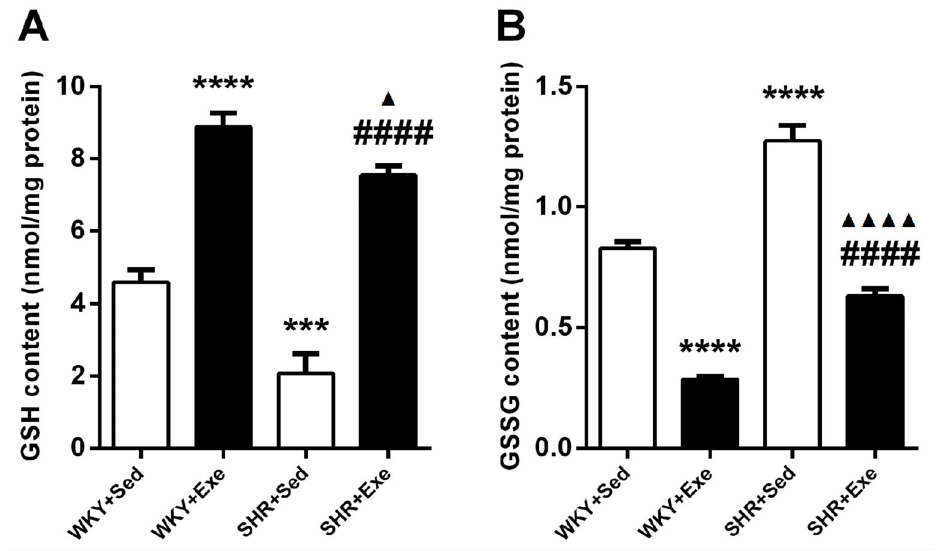
Figure 4. Cardiac GSH ( A ) and GSSG ( B ) levels were measured in sedentary or exercised Wistar-Kyoto rats (WKY + Sed, WKY + Exe) and in sedentary or exercised spontaneously hypertensive rats (SHR + Sed and SHR + Exe) after 16 weeks of moderate-intensity exercise. Results are reported as means ± SE (n=4 for A and n=5 for B ). ***P o 0.001, ****P o 0.0001 vs WKY + Sed group; m P o 0.05, mmmm P o 0.0001 vs WKY + Exe group; #### P o 0.0001 vs SHR + Sed group (ANOVA). GSH: reduced glutathione; GSSG: oxidized